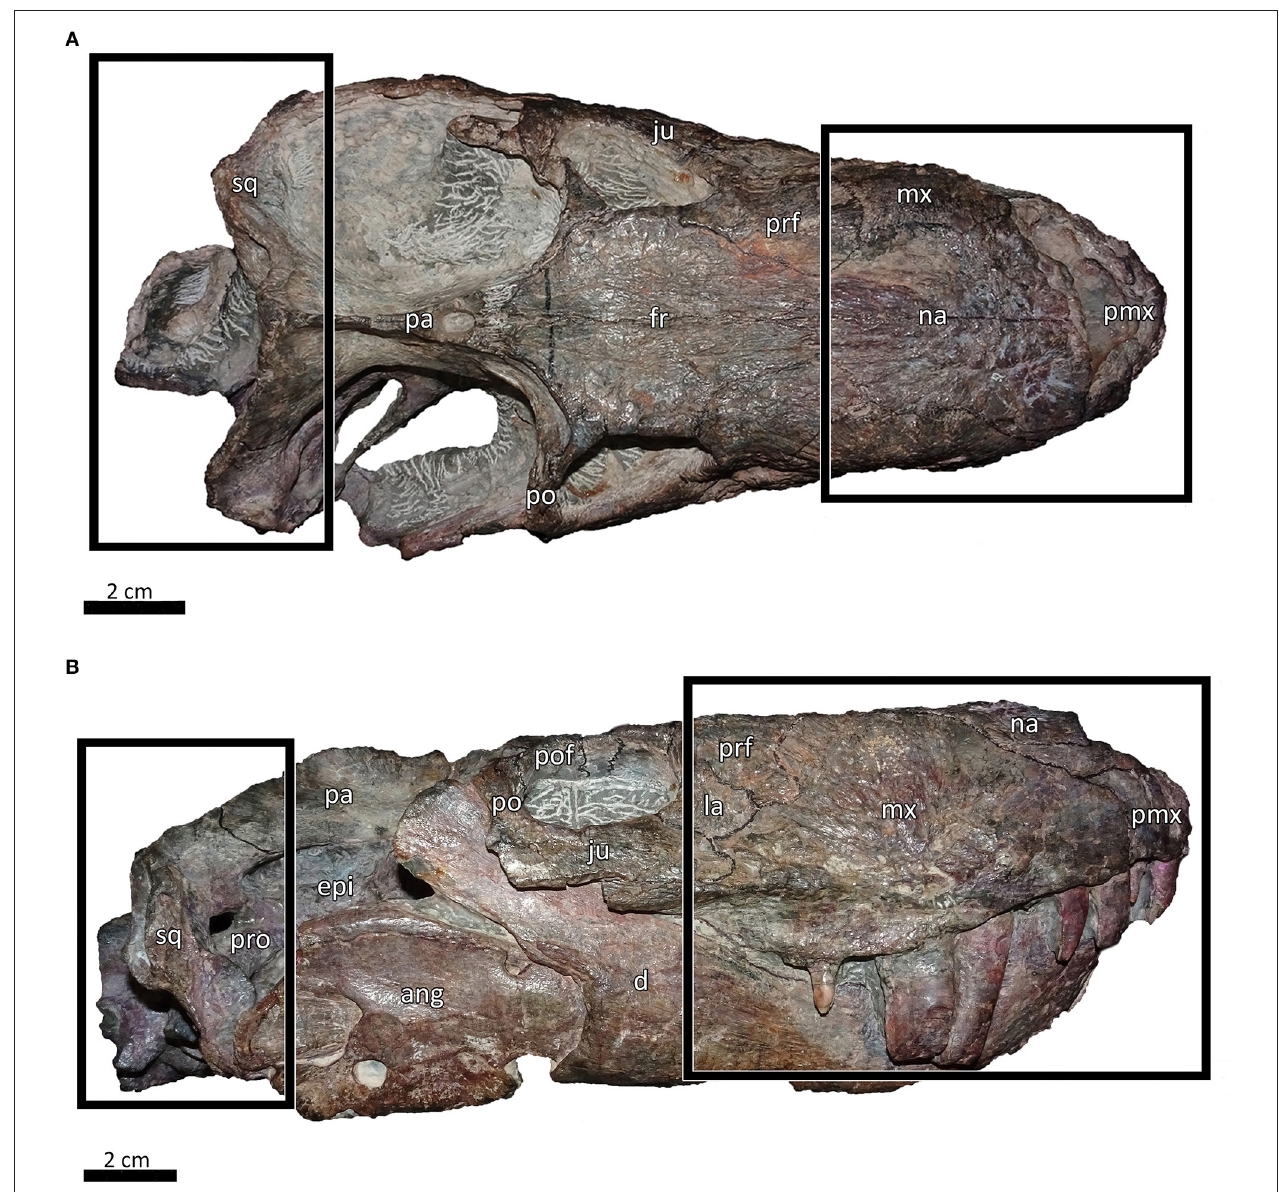
FIGURE 1 | Type specimen of Lycosuchus vanderrieti (US D173) in (A) dorsal and (B) right lateral view. Black boxes highlighting the portions of the cranium preserved in MB.R.995. ang, angular; d, dentary; epi, epipterygoid; fr, frontal; ju, jugal; la, lacrimal; mx, maxilla; na, nasal; pa, parietal; pmx, premaxilla; po, postorbital; pof, postfrontal; prf, prefrontal; pro, prootic, sq,